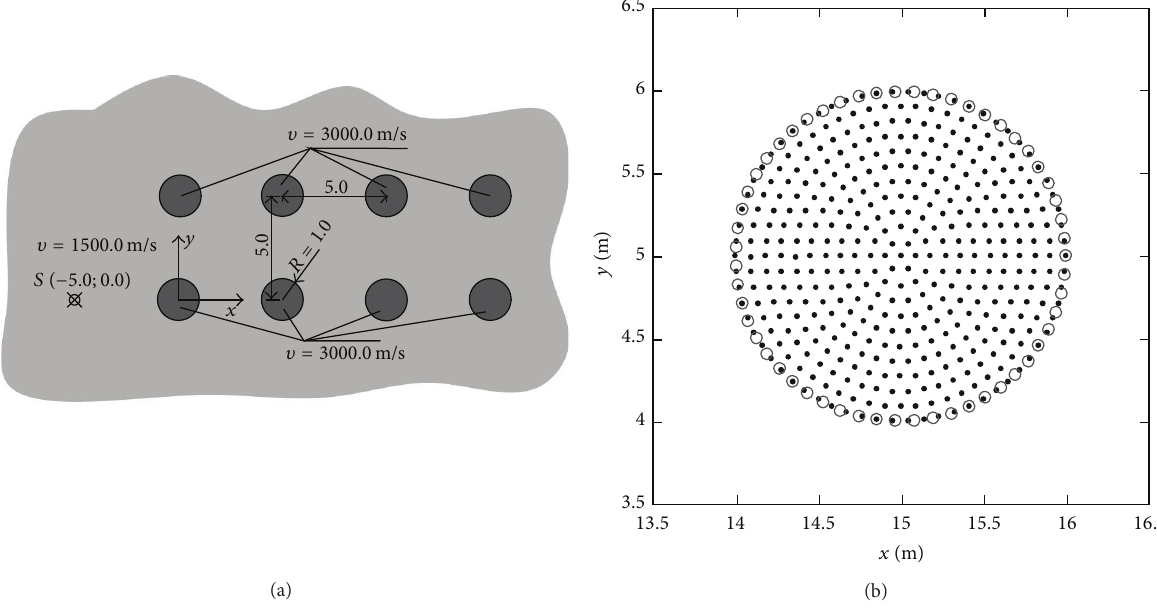
Figure 7: (a) Sketch for the heterogeneous medium with multiple subregions; (b) boundary and domain point distribution, considering the spatial discretization of an inclusion and adjacent